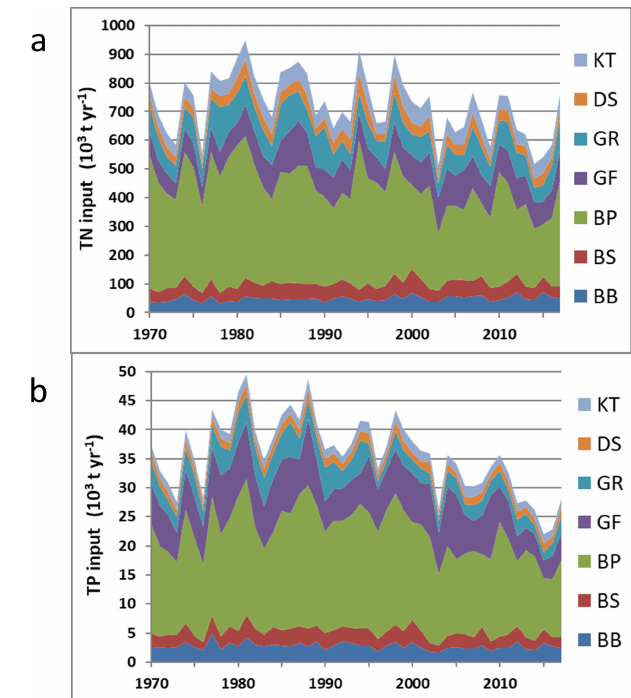
Figure 11. Long-term dynamics (1970–2017) of annual nitro- gen (a) and phosphorus (b) riverine inputs to the major Baltic Sea basins. BB – Bothnian Bay; BS – Bothnian Sea; BP – Baltic proper; GF – Gulf of Finland; GR – Gulf of Riga; DS – Danish straits; KT – Kattegat. Time (in years) is on the hor- izontal axis. Data source: updated from Savchuk (2018);